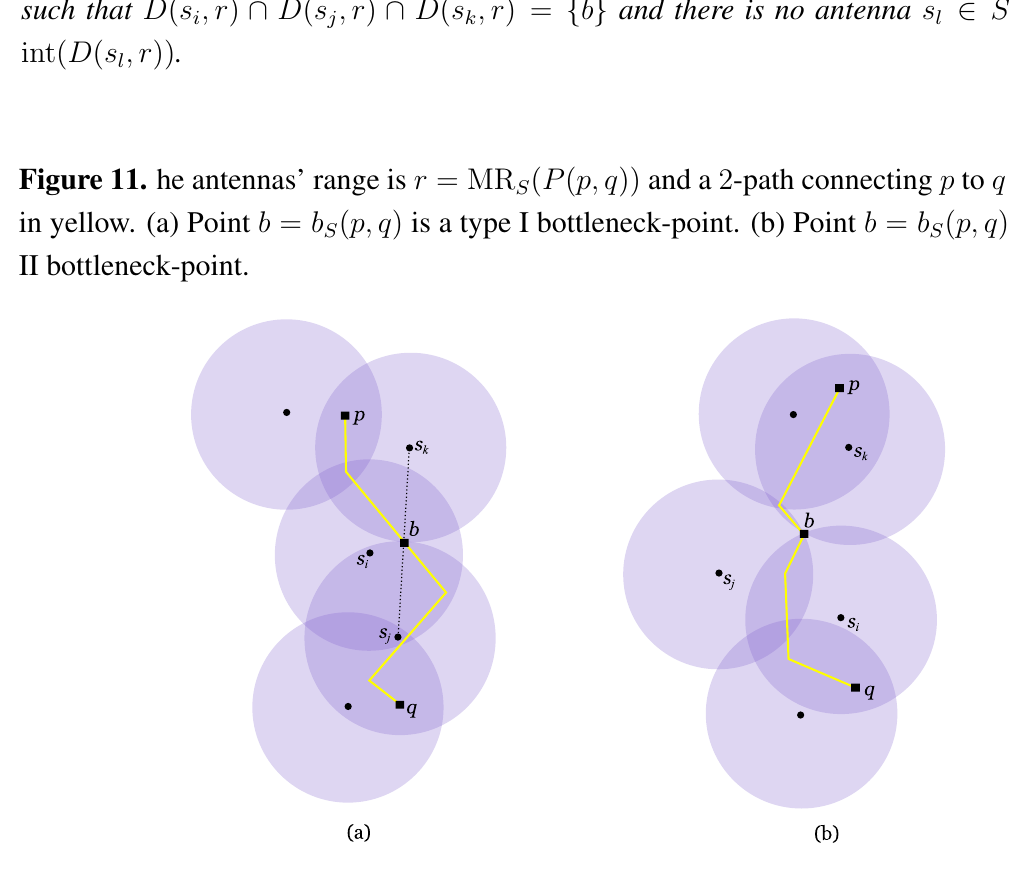
( P ( p, q )) and a 2 -path connecting p to q is shown S ( p, q ) is a type I bottleneck-point. (b) Point b = b S